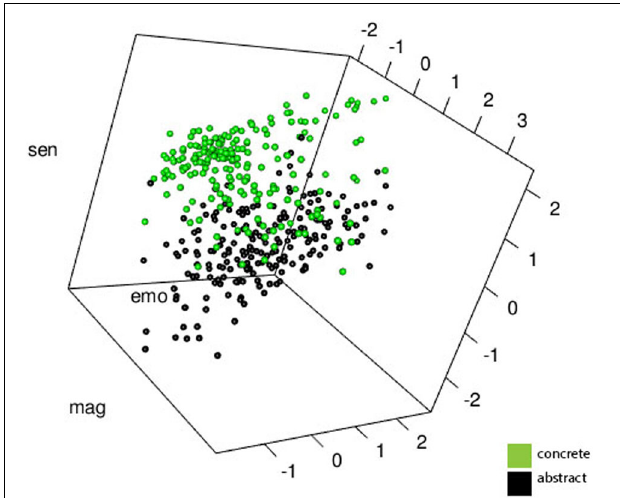
FIGURE 2 | Three Dimensional Scatterplot Representing Abstract and Concrete Word Meaning. This view represents rotation about the axes/planes defined by the factors: Sens, sensation; Mag, magnitude; and Emo, emotion.